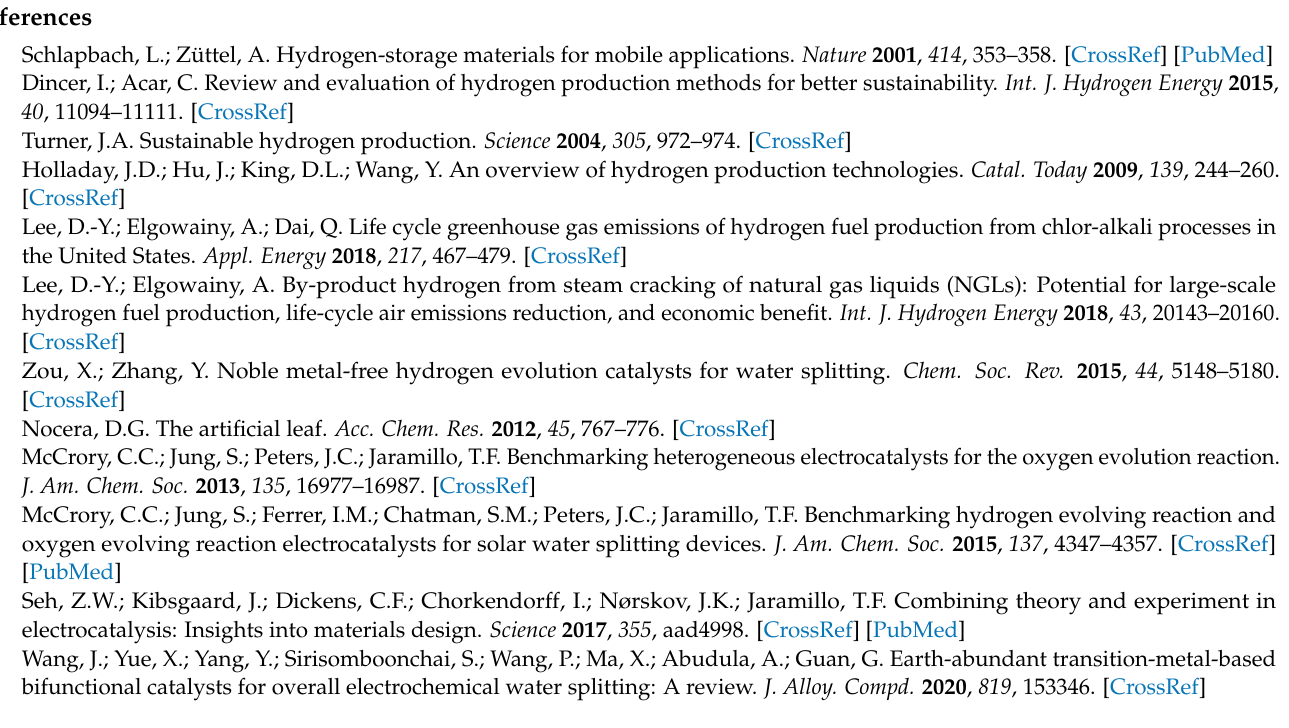
10.3390/nano11123379/s1, TOF calculation, Figure S1: TEM images and corresponding particle size distribution of (a,b) A-NiO NPs/rGO (300 ◦ C) and (c,d) A-NiO NPs/rGO (500 ◦ C). Inset images of (a) and (c) are enlarged views, respectively. Figure S2: TEM images and corresponding particle size distribution of (a,b) NiO NPs/GO and (c,d) A-NiO NPs/GO. Inset images of (a) and (c) are enlarged views, respectively. Figure S3: XRD spectra of the NiO NPs/rGO and A-NiO NPs/rGO. Figure S4: (a) EDS spectrum of A-NiO NPs/rGO, (b) enlarged view of (a). Detected Cu peaks were originated from the Cu grid. Figure S5: (a) EDS mapping and (b) SAED image of NiO NPs/rGO. Figure S6: XPS spectra of (a) C 1s, (b) O 1s, (c) Ni 2p 3/2 for NiO NPs/GO (upper) and A-NiO NPs/GO (lower). Figure S7: LSV curves and corresponding overpotential histograms at 10 mA cm − 2 in (a,b) HER and (c,d) OER with different annealing temperature. Figure S8: LSV curves and corresponding overpotential histograms at 10 mA cm − 2 in (a,b) HER and (c,d) OER with different annealing atmosphere. Figure S9: LSV curves of the catalysts which are mass-normalized in (a) HER and (b) OER. Figure S10. (a) TEM image and (b) corresponding particle size distribution of A-NiO NPs/rGO after durability test. Figure S11. XPS spectra of Ni 2p 3/2 for A-NiO NPs/rGO at an initial state (upper) and after durability test (lower). Figure S12: Schematic illustration of HER mechanism for Ni species in alkaline media. Figure S13: Schematic illustration of OER mechanism for Ni species in alkaline media. Table S1: ICP-OES data of catalysts. Table S2: Collected data of transition metal-carbonaceous support hybrid catalysts for HER. Table S3: Collected data of transition metal-carbonaceous support hybrid catalysts for OER. Video S1: Overall water splitting and gas generation by NiO NPs/rGO at the anode and A-NiO NPs/rGO at the